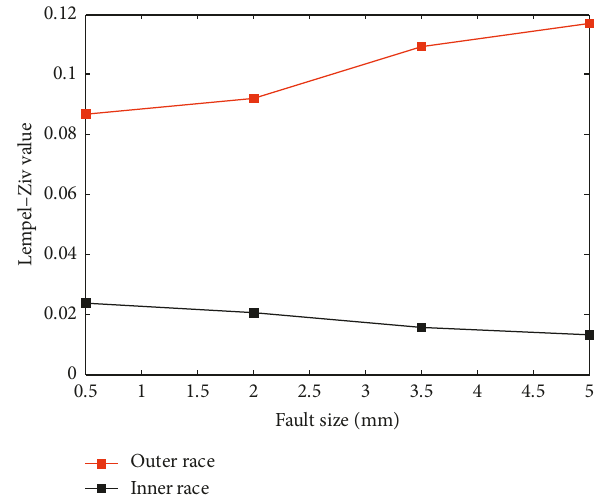
Figure 5: The Lempel–Ziv trend chart of the original signal.